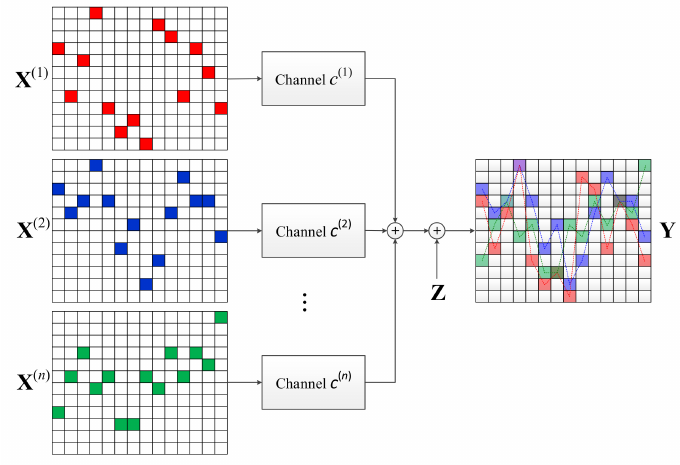
Figure 4. Conceptual description of multiple-access of trellis tone modulation (TTM)